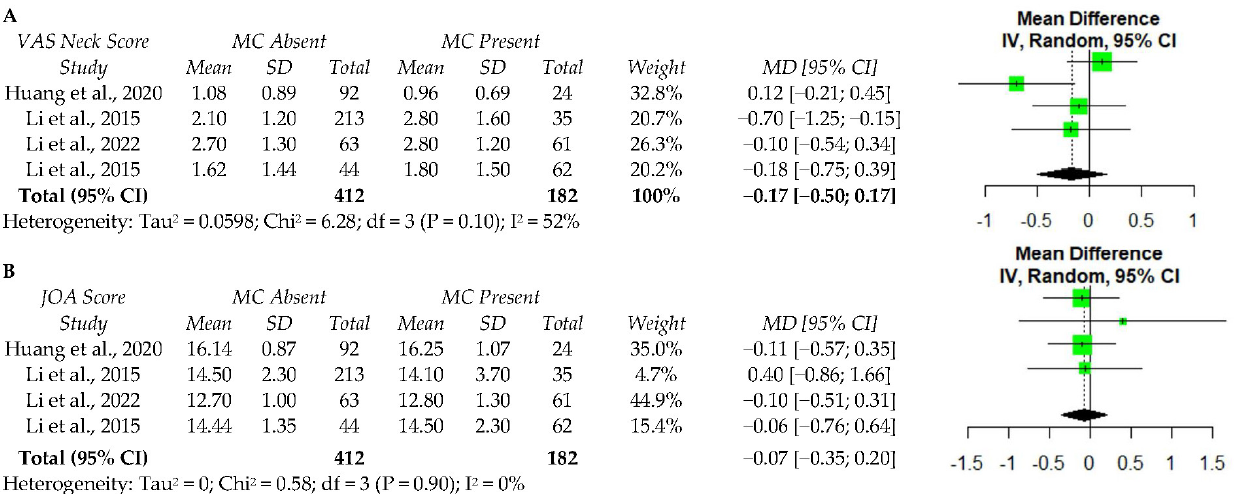
Figure 2. The meta-analysis of one-year postoperative VAS neck score ( A ) and JOA score ( B ) following ACDF. VAS—visual analog scale; MC—Modic changes; SD—standard deviation; MD—